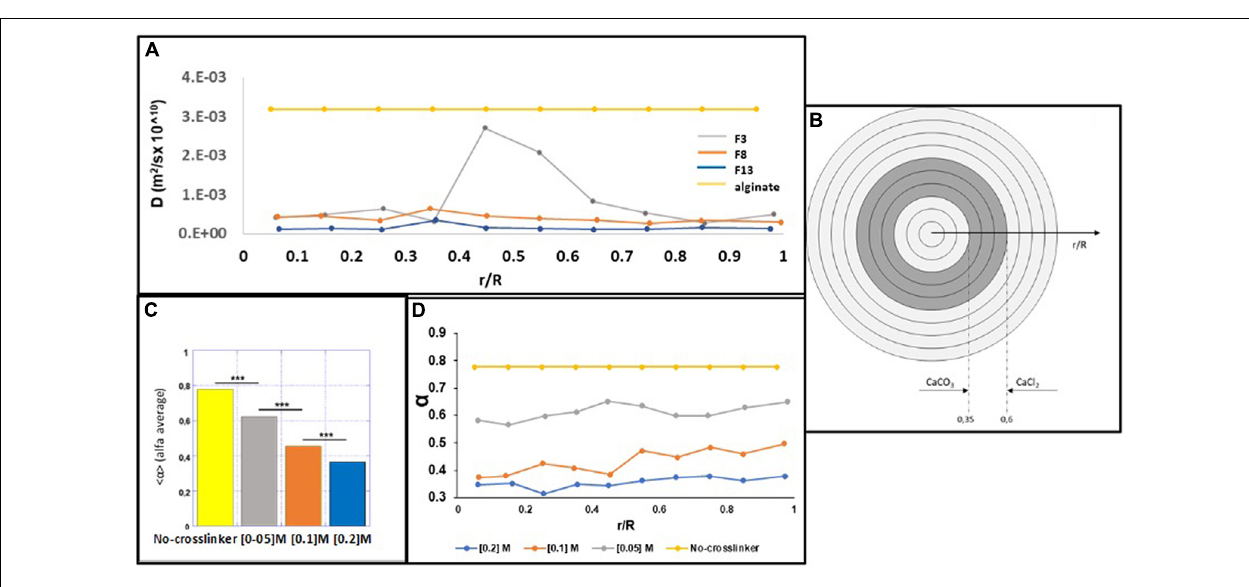
FIGURE 4 | MPT microsphere analysis. (A) The D coefficient was correlated to the normalized distance along the radius of the microspheres for all formulations. (B) Internal and external gelation mechanisms for the concentration of 0.05 M CaCl 2 and the non-polymerization area of the bare alginate. (C) Average values of α for the bare alginate and F3, F8, and F13 formulations. (D) α Values are plotted as a function of the normalized distance along the radius from the center of the